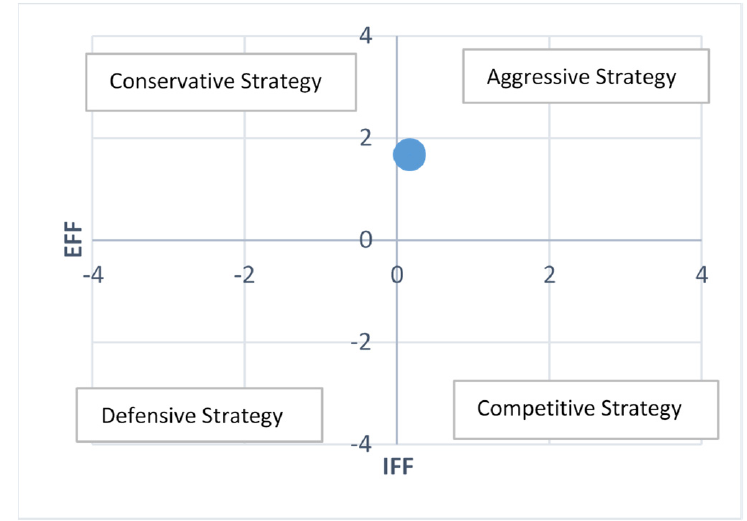
Fig. 5. Position of smart city strategies in Tehran